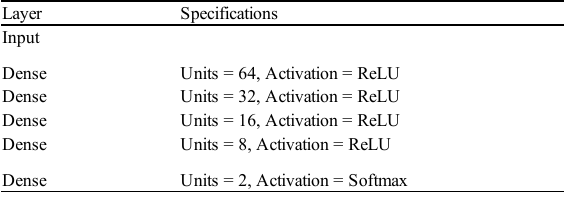
Table 2 . Structure of DNN.